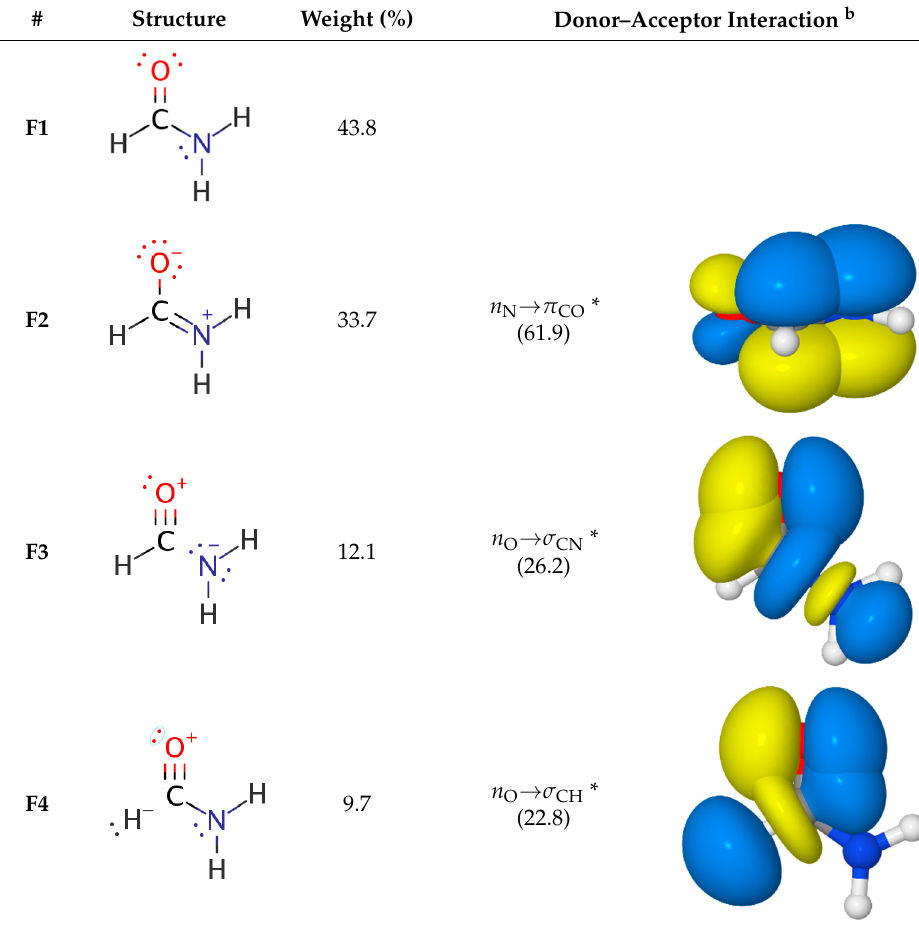
Table 3. NRT resonance hybrid of formamide a .